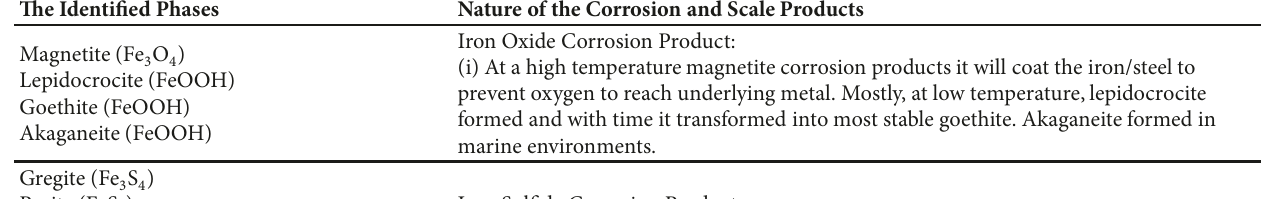
Table 1: Summary of the identified phases of the inorganic materials (i.e., the insoluble part or nonhydrocarbon) separated from the hydrocarbon (dichloromethane soluble part) of the sludge deposits, and its nature [1].